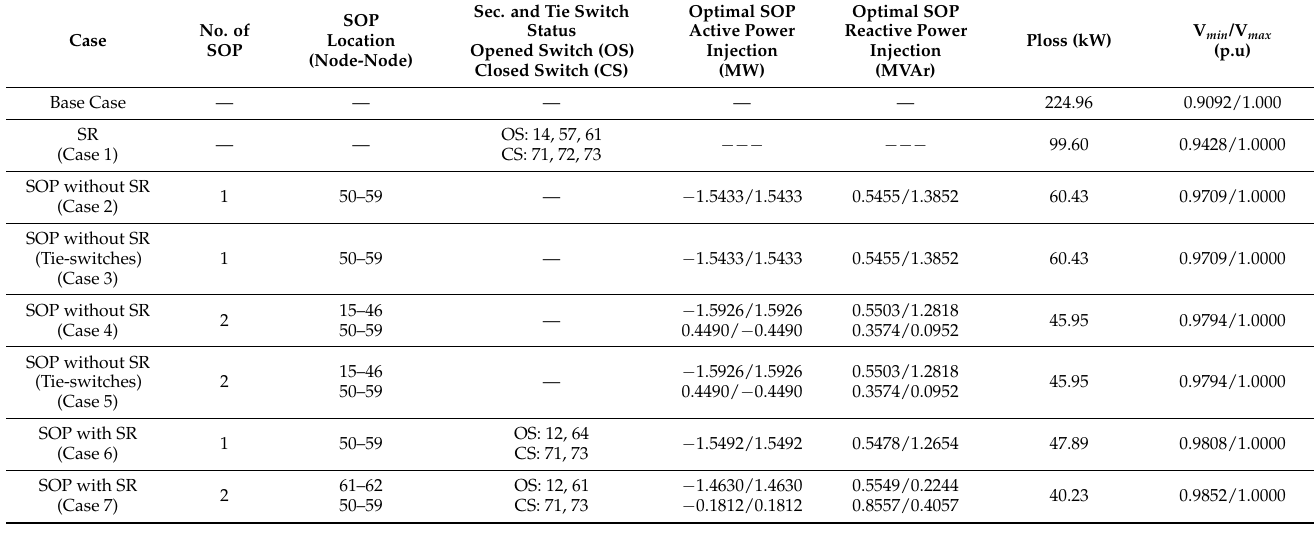
Table 2. Numerical results for IEEE 69-Node with and without SOP installation.